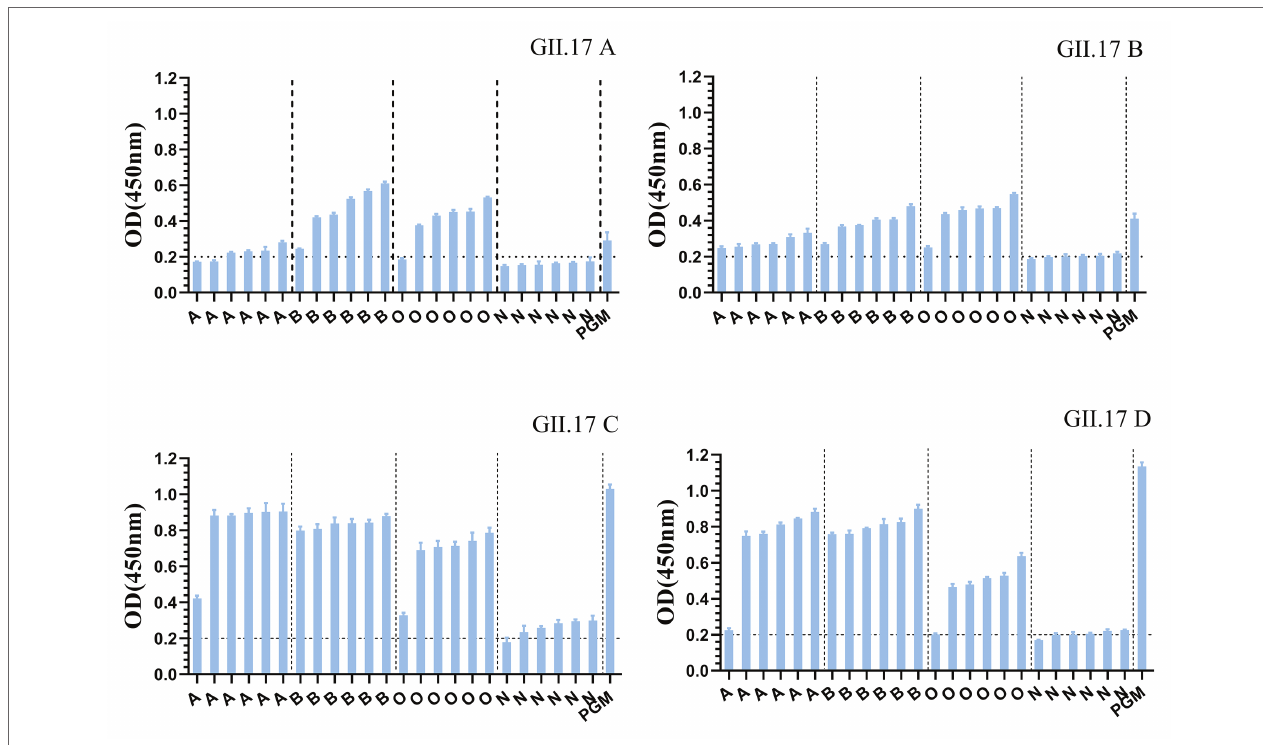
FIGURE 3 | Binding of four clusters of GII.17 NoV P particles to saliva samples. GII.17 P particles were assayed for the binding property to saliva samples phenotyped by ELISA. Saliva samples from six individuals of each carbohydrate type (type A, B, O, and N), pig gastric mucin (PGM) were coated onto 96-well microplates, and then add P protein from four clusters of GII.17 viruses (GII.17 A, GII.17 B, GII.17 C, and GII.17 D). Shown are mean OD values with standard errors of P particles binding to saliva type A, B, O, non-secretor, and pig gastric mucin (PGM). Each group was sorted from the lowest to the highest in terms of the intensity of binding to saliva according to the OD 450 nm readings. Dotted line represents the cut-off value for samples considered positive. O, A, B, and N represent the type O (H antigen), A, B, and non-secretor saliva,